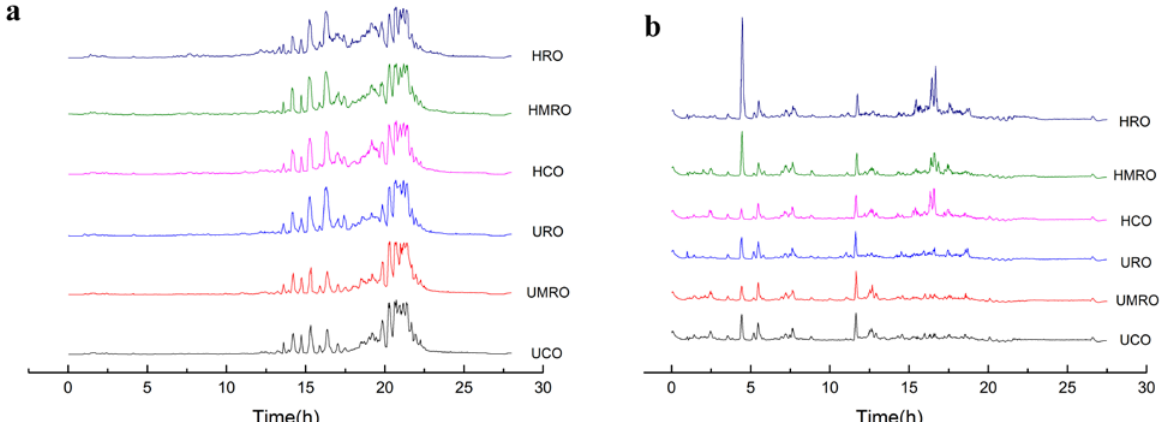
Figure 8. Total ion chromatography (TIC) of camellia oil before and after heating based on LC–ESI– MS/MS. ( a ) TIC in ESI+ mode; ( b ) TIC in ESI − mode). The CO, MRO, and RO obtained after heating for 16 h were named heated crude oil (HCO), heated moderately refined oil (HMRO), and heated refined oil (HRO), respectively. UCO: untreated crude oil. UMRO: untreated moderately refined oil. URO: untreated refined oil.